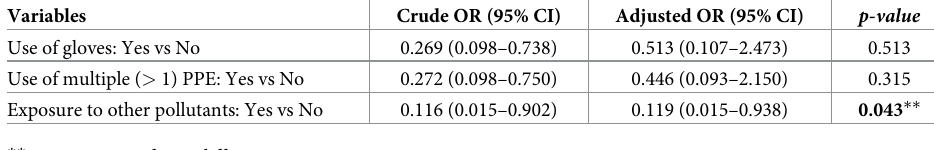
Table 4. Risk factors associated with detection of respiratory